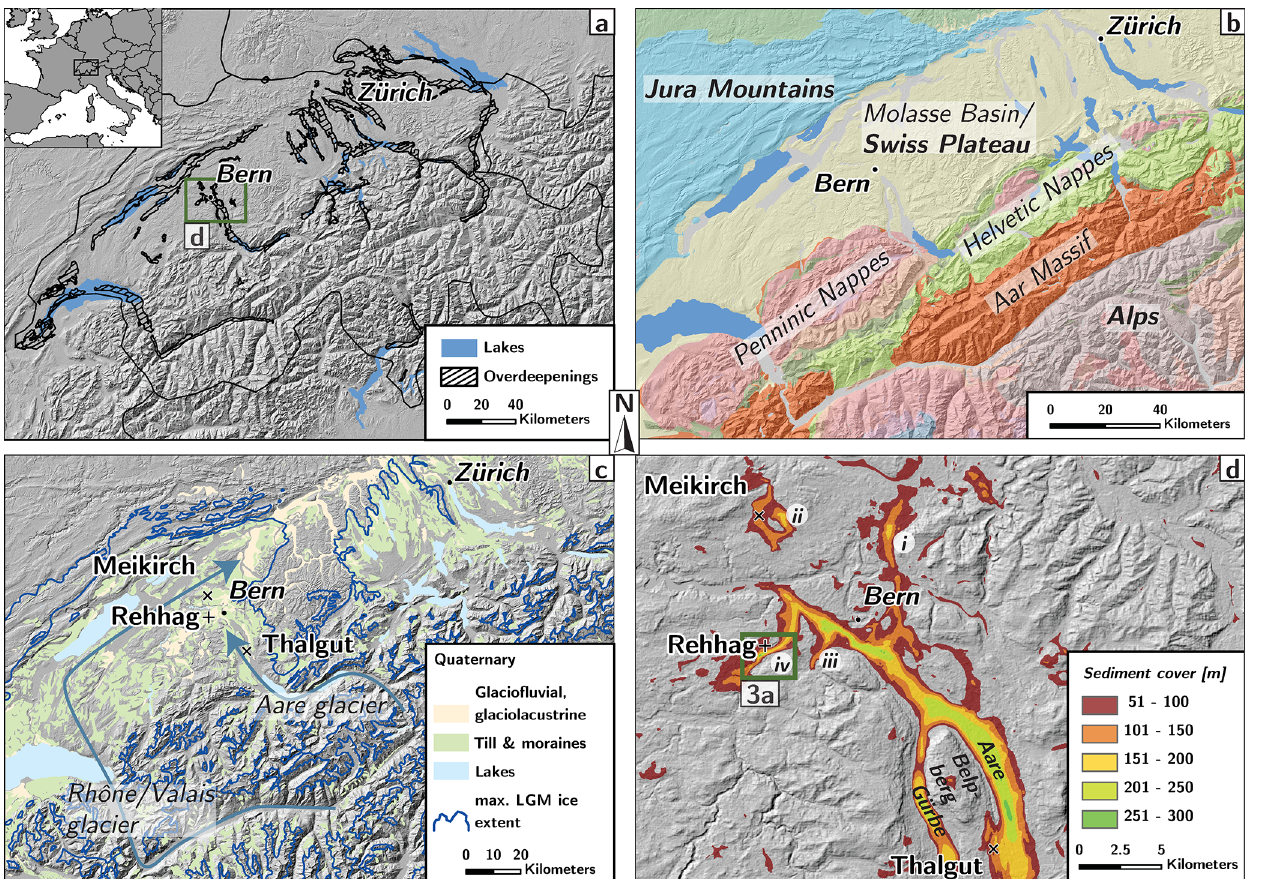
Figure 1. (a) Distribution of overdeepenings in the Swiss Alps and Plateau. For data availability, see below. The green box outlines the extent of the study area as shown in (d) . (b) Location map of the geographic (bold font) and geologic (normal font) settings in the vicinity of the study area. (c) Surface distribution of deposits from the last glaciation. The maximum extent of glaciers during the LGM is indicated along with the flow directions (green arrows) of the Rhône and Aare ice streams (modified from Ehlers et al., 2011). The locations of the Meikirch, Rehhag, and Thalgut drill sites are marked. (d) This map shows the varying thickness of the sediment fill in the MAV overdeepening as derived from the bedrock model (see below). The locations of the Meikirch, Rehhag, and Thalgut drill sites are marked. Numbers (i) to (iv) indicate branches of the MAV overdeepening as mentioned in the text (Sect. 2). These branches are (i) the N-directed continuation of the main overdeepening, which is ca. 8.5km long, (ii) an isolated bedrock depression (Meikirch trough) located 2km north of the distal termination of the main trough, (iii) a ca. 2km-long SW-oriented branch situated about 1km SW of Bern, and (iv) a ca. 6.5km-long SW-directed branch, referred to as the Bümpliz trough. The green box shows the location of the map in Fig. 3, in which the local geology and morphology at the Rehhag site atop the Bümpliz trough (iv) are presented in more detail. All elevation data are based on ASTER (NASA/METI/AIST/Japan Spacesystems and U.S./Japan ASTER Science Team, 2019). The Reber and Schlunegger (2016) bedrock topography in (d) is part of the bedrock surface model for Switzerland in (a) . The Swiss-wide model is a composite of various data sets (Jordan, 2010; Dürst Stucki et al., 2010; Dürst Stucki and Schlunegger, 2013; Reber and Schlunegger, 2016), and the model is available via the Federal Office of Topography (Swisstopo). A free-of-charge high-resolution reconstruction of the bedrock topography in the Canton of Bern (Reber and Schlunegger, 2016) with a 10m resolution in elevation is available through the canton’s geodatabase (http://www.geo.apps.be.ch/de, last access: 24 June 2021). The thickness of the Quaternary fill has been determined through the elevation difference between the modern topography and the bedrock surface (e.g., Dürst Stucki and Schlunegger,